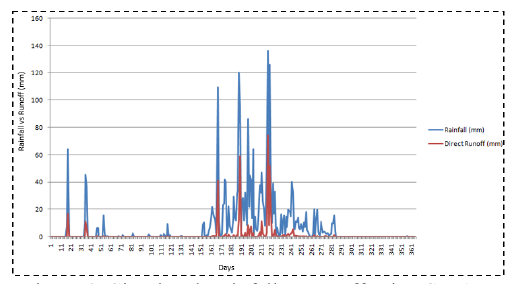
Figure 9. Simulated Rainfall – Runoff using SWAT.